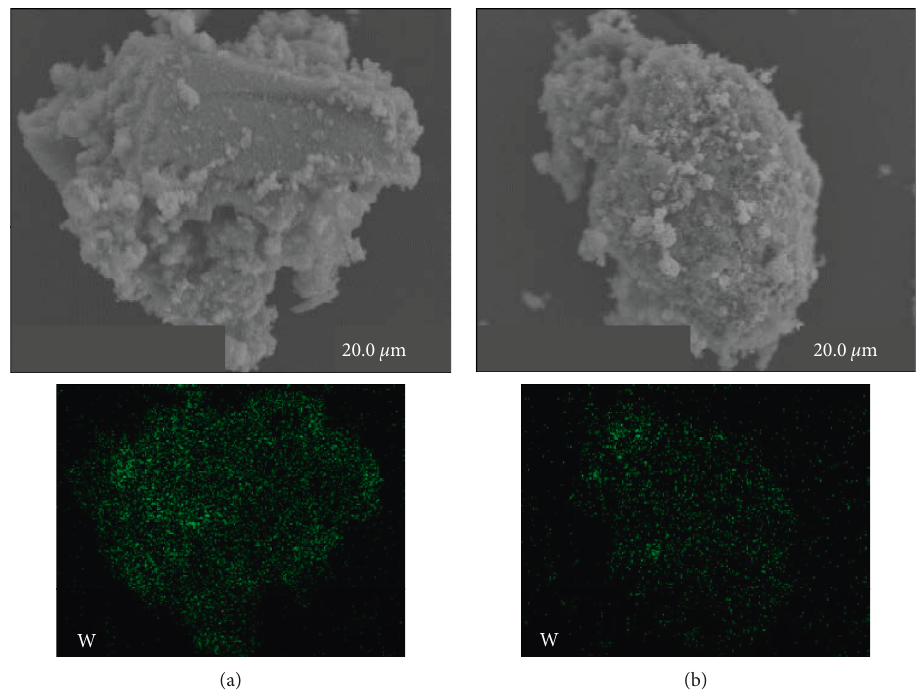
Figure 4: Elemental distribution by EDX mapping for (a) WO